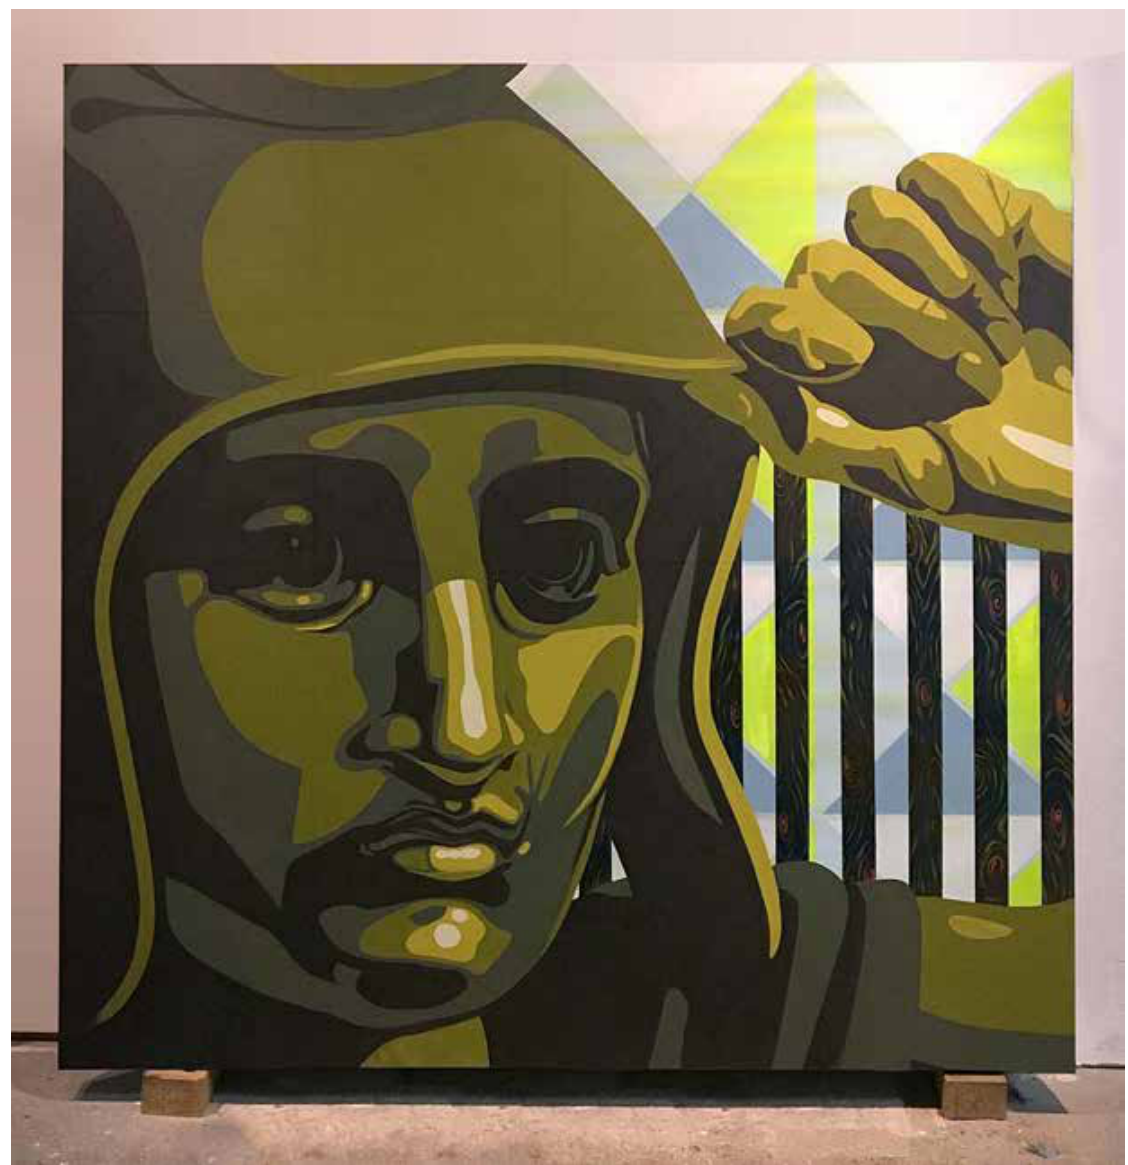
Figure 8: Jenny Roesel Ustick, Crux, 2018. Acrylic on canvas, 162.4 x 162.4